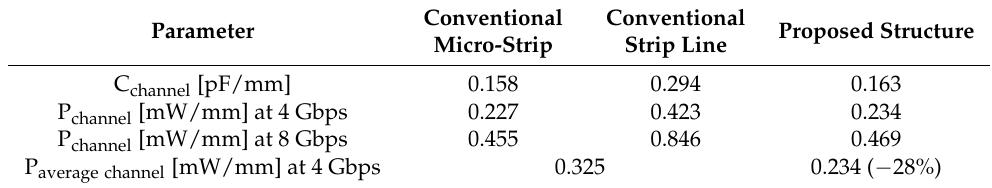
Table 2. Dynamic power consumption of proposed structure and conventional channel structure.